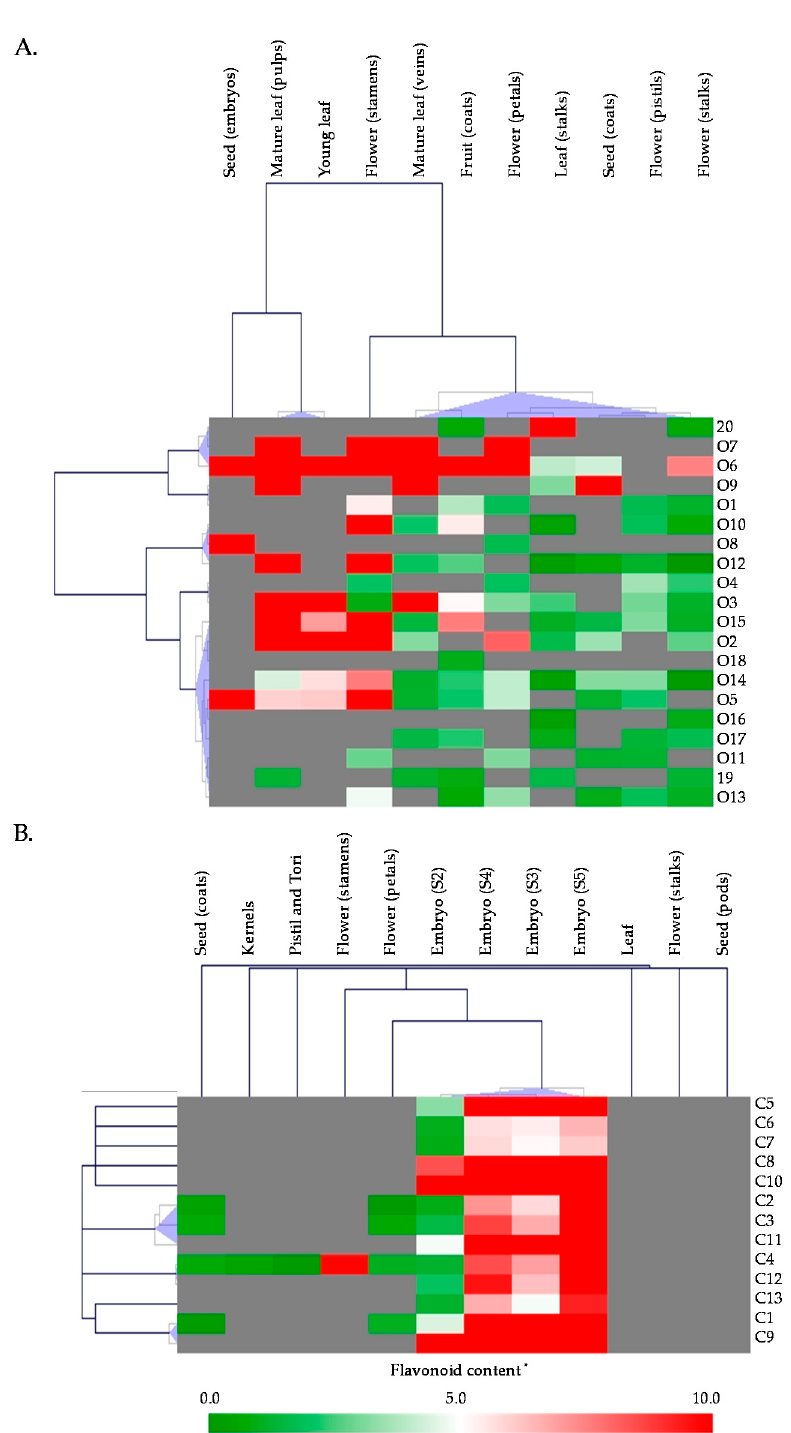
Figure 4. Comparative analysis of flavonoid contents and compositions different tissues of Nelumbo nucifera . Data were compiled from Chen et al. [33] and Li et al. [35]. ( A ) Comparative analysis of flavonoids aglycones and FOGs in 11 different tissues. ( B ) Comparative analysis of FCGs in 12 tissues and/or developmental stages including embryo (the major accumulation site of FCGs in Nelumbo nucifera ) at five maturation stages. The names and structures of the flavonoids are presented in Figure 3. * Contents are expressed in mg.100 g − 1 FW for all tissues except for seed embryo for which contents are expressed in mg.100 g − 1 DW in ( A ).